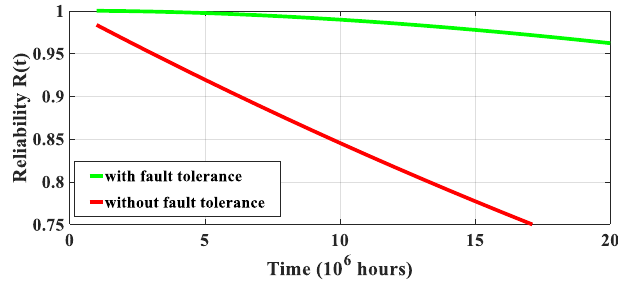
Figure 8. Reliability curve.